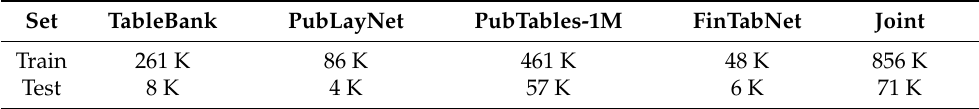
Table 1. The number of utilized images in four employed